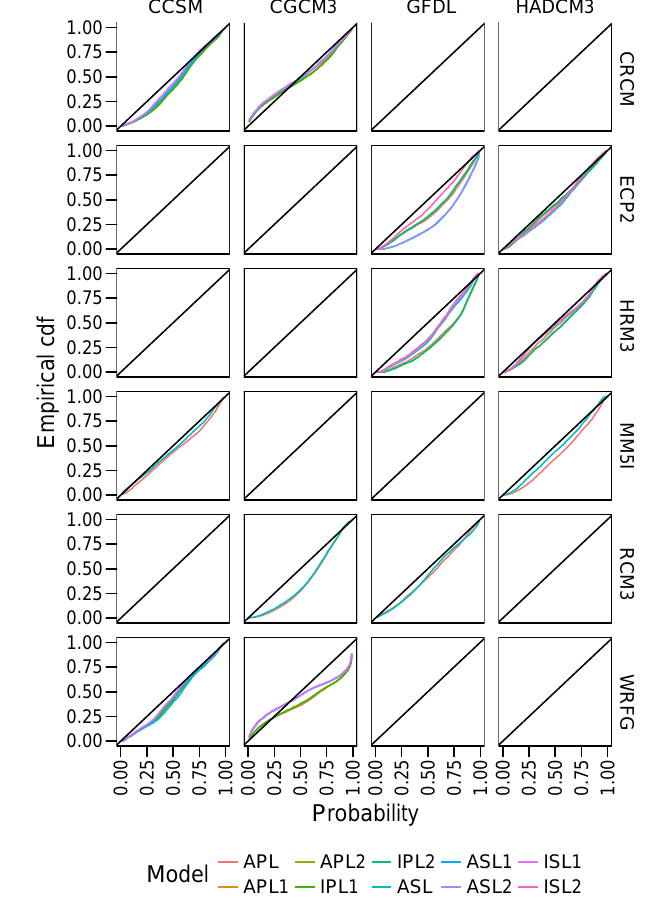
Figure 4. Empirical CDFs of the p values from the Ljung–Box test of independence of the transformed residuals (across all locations) for each GCM–RCM combination, separated by the model fit. The black line is the CDF of a standard uniform distribution. This fig- ure demonstrates the temporal independence of transformed errors required by Assumption A3.